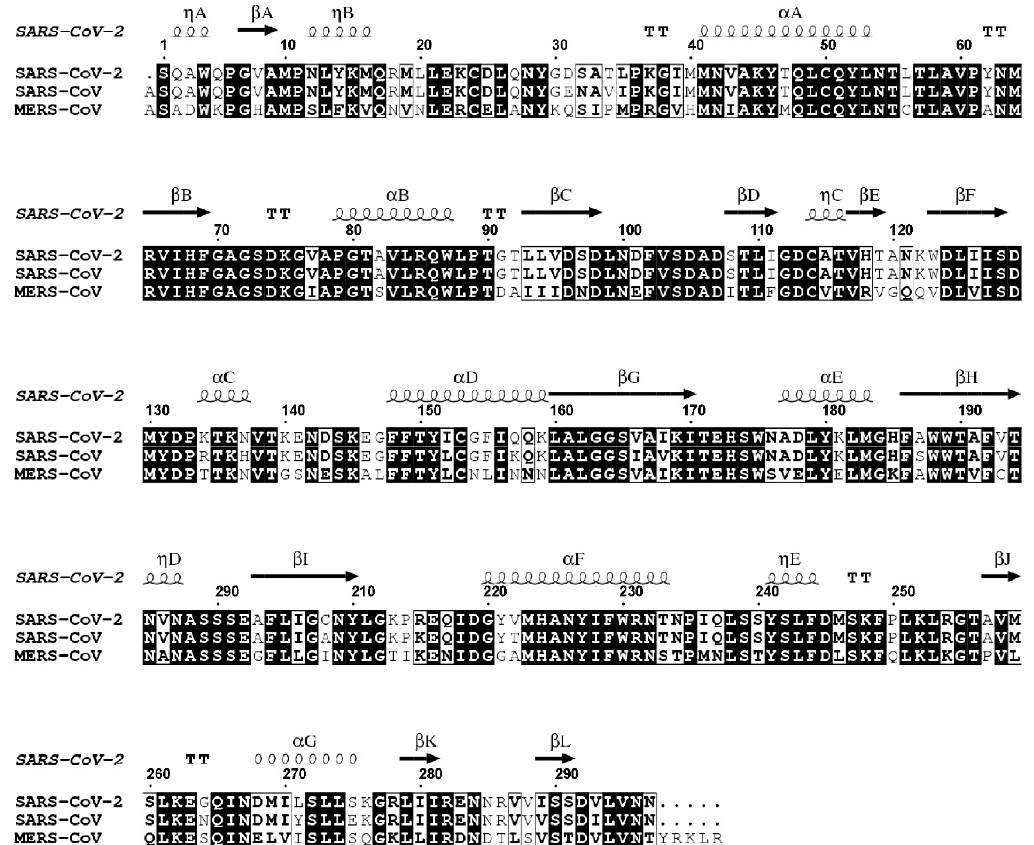
Figure 3. Sequence alignment of 2 ′ O-MTases (e.g., NSP16) viral proteins from SARS-CoV-2, SARS-CoV and MERS-CoV. Residues that are fully conserved are shown in solid black boxes; those with identity of 70% or higher are shown in white boxes. The secondary structure of SARS-CoV-2 NSP16 derived from the crystal structure (PDB ID 6WKQ) is shown above the alignments. Figure generated with the program ESPript 3.0 [11].